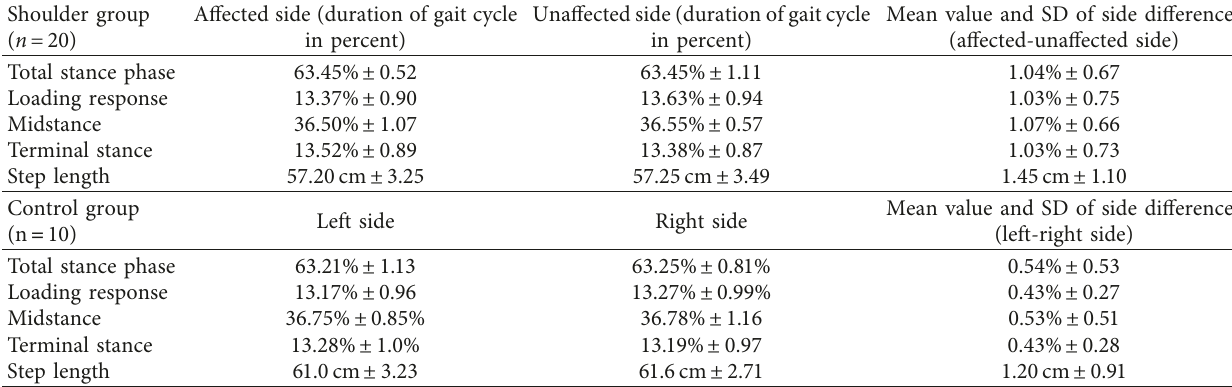
Table 1: Gait parameters of shoulder group compared to control